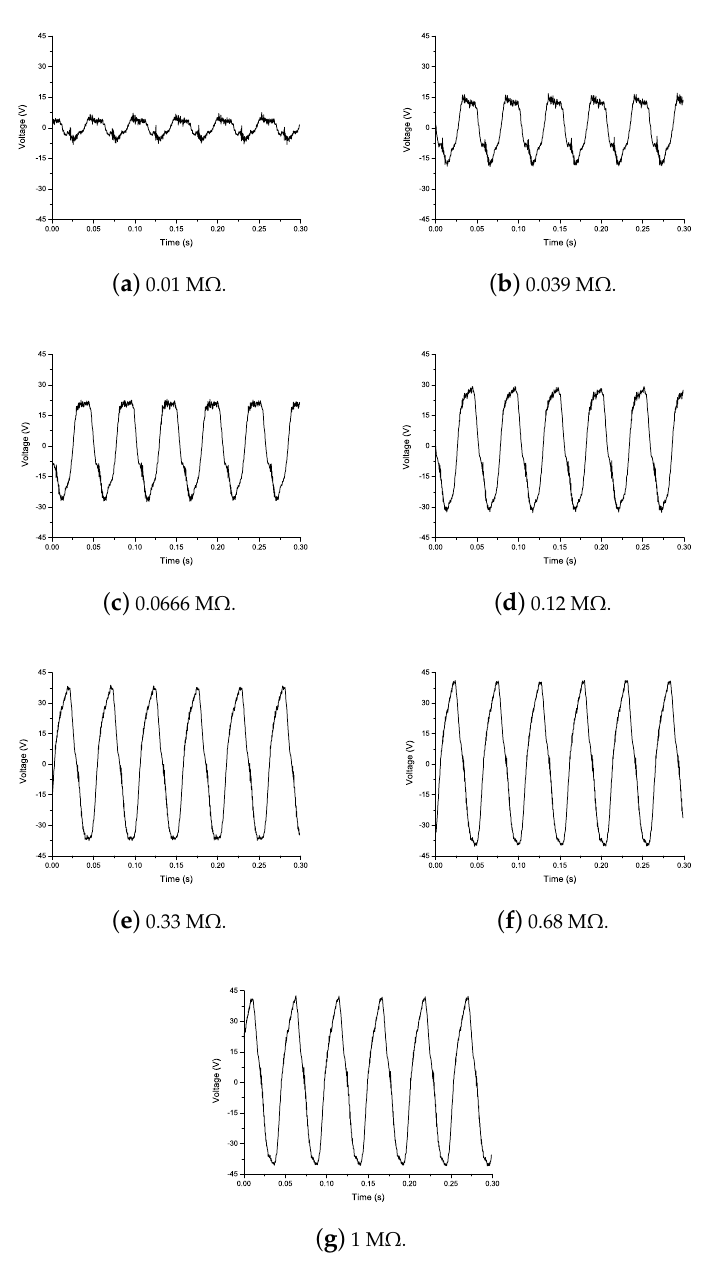
Figure 6. Experimental output voltage for different